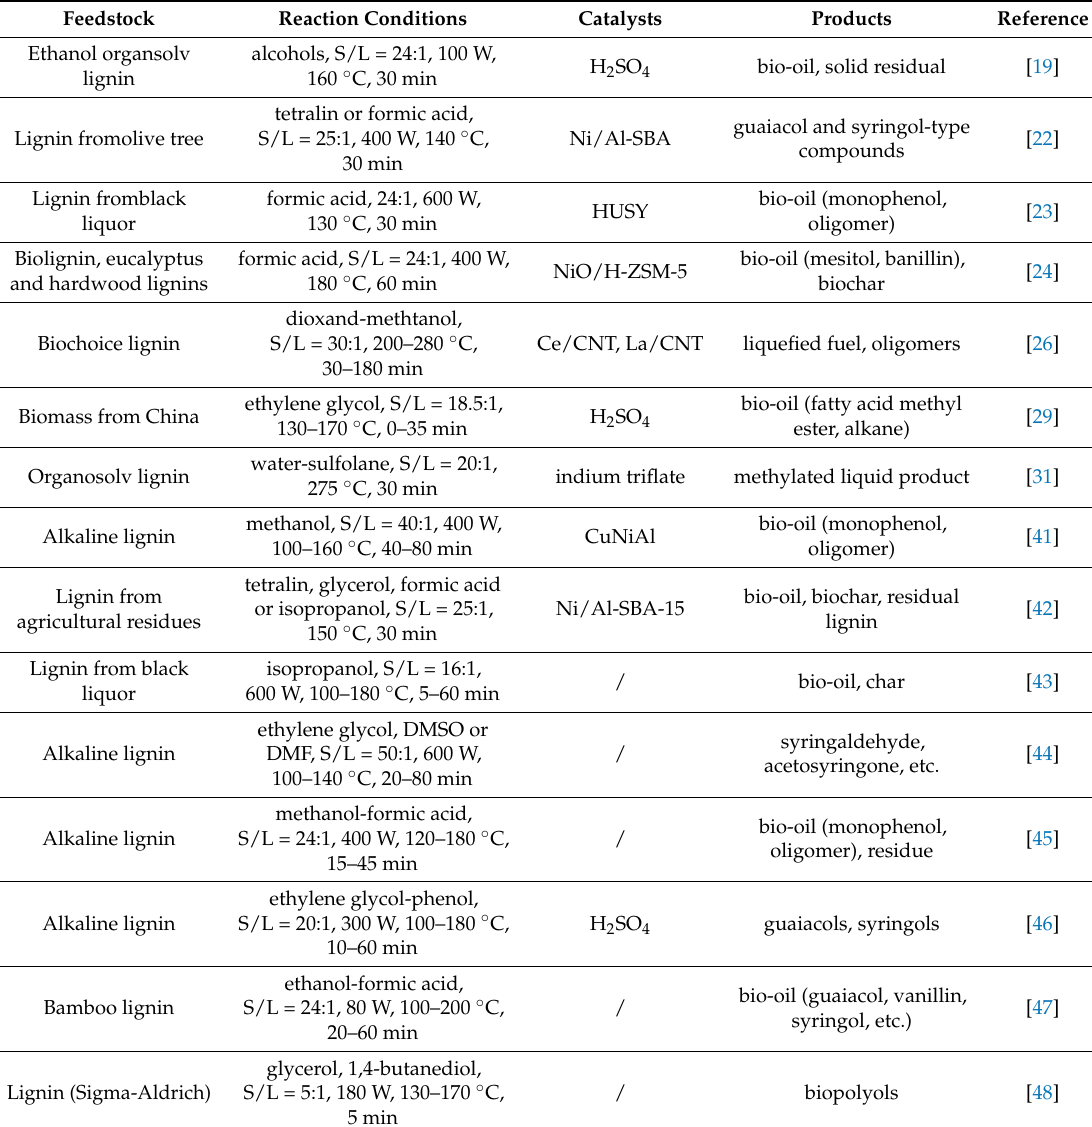
Table 1. Summary of microwave assisted liquefaction of lignin under different reaction